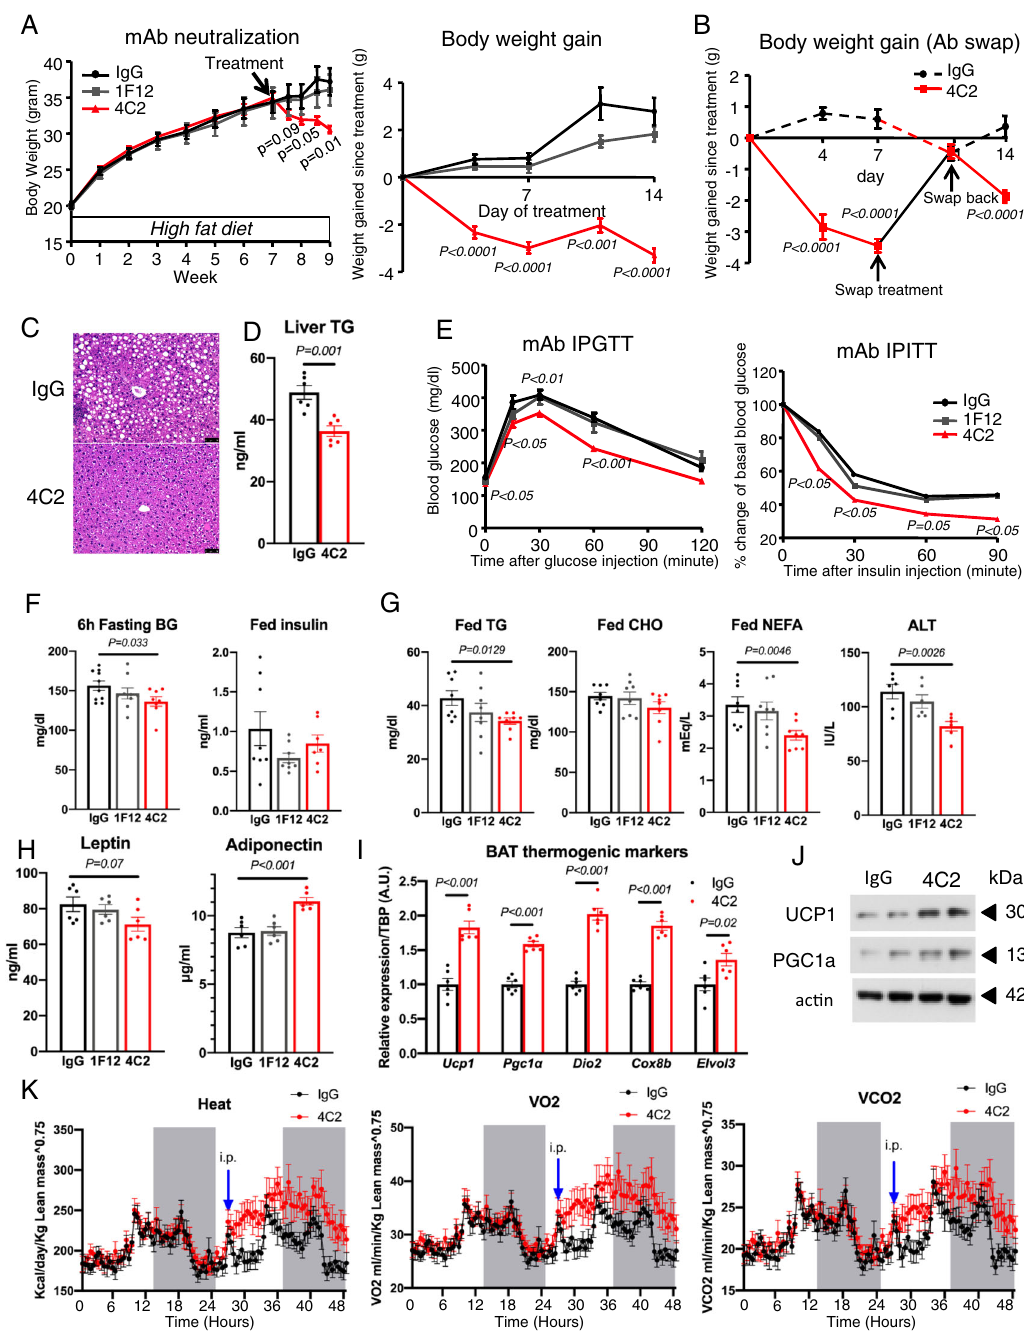
Fig. 7 | Effects of scEMC10 neutralization on diet-induced obesity and meta- bolic homeostasis. A Body weight (left) and body weight gain (right) of C57BL/6J male mice fed with HFD before or after IP injected with 3mg/kg BW antibody as indicated twice a week. (IgG, black circle. mAb-1F12, gray square. mAb-4C2, red triangle) ( n =9 per group). B Body weight gain of HFD male mice IP injected with 3mg/kg BW 4C2 antibody or control IgG twice a week. 7 days later, the two anti- bodiesswappedwitheachother,andthen4dayslater,swappedbackfollowedby3 otherdays oforiginal treatment (IgG,dashed/black. mAb-4C2,solid/red) ( n =5 per group). C Representative images of H&E-stained sections of liver from male mice treated with IgG or 4C2 antibodies. Scale bar, 50um. D TG content of liver from male mice treated with IgG (black) or 4C2 (red) antibodies for 3 weeks ( n =6 per group) .E Glucosetolerance(left)andinsulintolerance(right)ofmalemicetreated withIgG(blackcircle),1F12(graysquare)or4C2(redtriangle)antibodies( n =9per